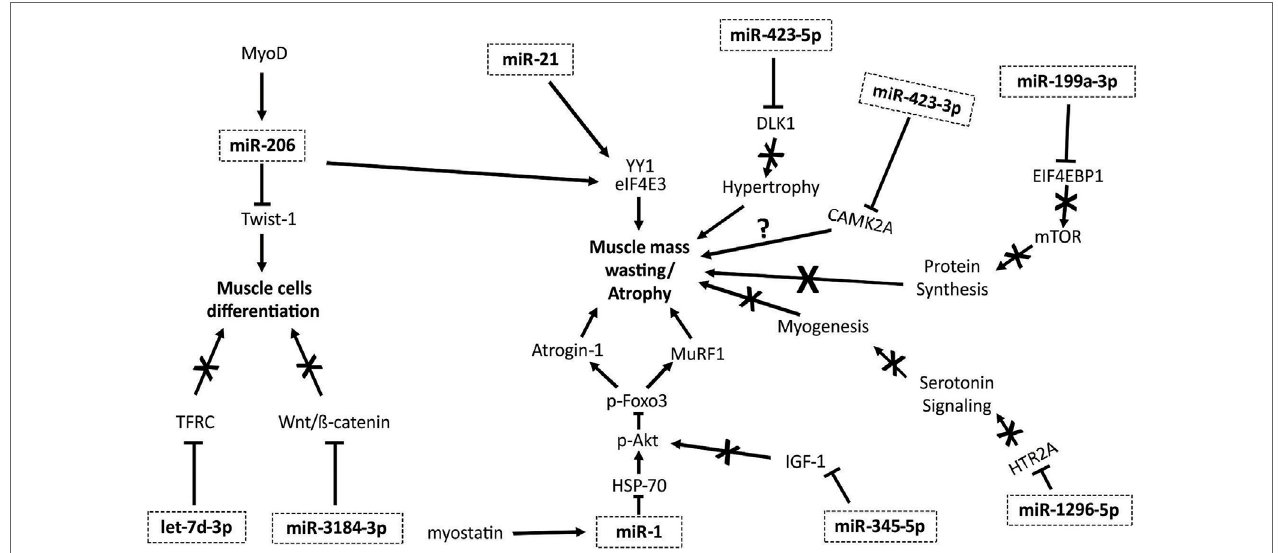
FiGURe 1 | myomiRs and muscle mass wasting and atrophy pathways. MyoD is able to activate miR-206, promoting an inhibiting effect on Twist-1 protein, diminishing muscle cell differentiation (53). miR-206 and miR-21 regulate the action of YY1 and eIF4E3, promoting muscle mass wasting (43). Myostatin increases miR-1 expression, promoting a reduction in heat shock protein 70 (HSP70) action, decreasing Akt phosphorylation, and its regulation of Foxo3. When Foxo3 is not phosphorylated, the expression of several proteins that induce atrophy, including Atrogin-1 and MuRF1, are enhanced (54). The let-7d-3p downregulates transferrin receptor (TFRC), affecting muscle cell proliferation and myogenic differentiation (7). miR-3184-3p inhibits Wnt/ β -catenin pathway, impairing myogenic differentiation (7). mir-345-5p downregulates genes and proteins involved in IGF1 pathway, decreasing anabolic signaling. miR-1296-5p regulates HTR2A gene, reducing the participation of serotonin in the induction of myogenesis (7). miR-199a-3p affects the EIF4EBP1 gene, reducing mTOR pathway activity, interfering in protein synthesis (7). miR-423-3p promotes reduction of calcium signaling, affecting CAMK2A gene (7). miR-423-5p downregulates DLK1, what is involved with muscle hypertrophy; thus, reducing this capacity